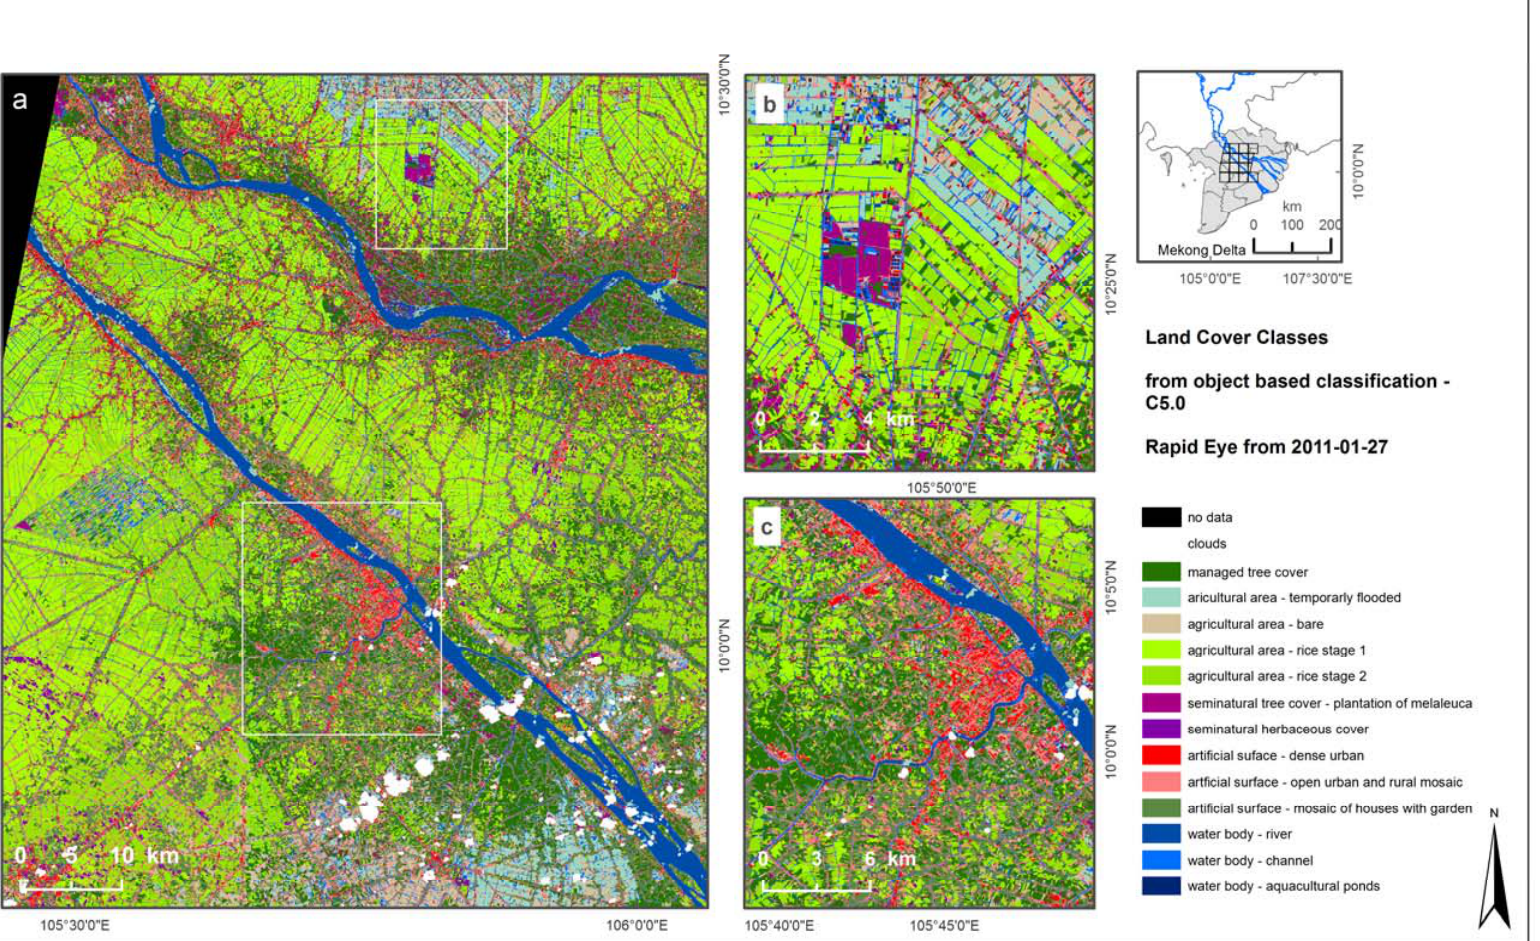
Figure 3. Classification result of TWOPAC run with Rapid Eye mosaic (2010-01-27) from the central part of the Mekong Delta—subset of object-based result ( a ); detail on rural area and natural tree area ( b ); detail on urban area ( c